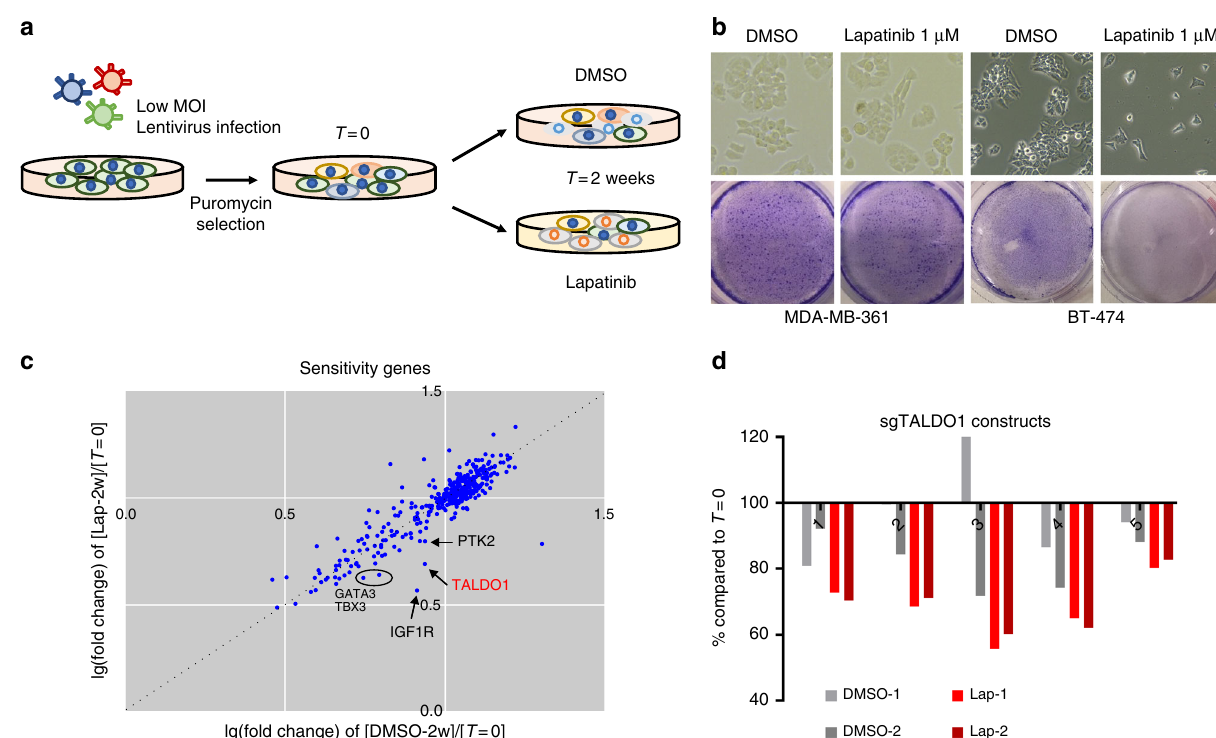
Fig. 1 Pooled CRISRP/Cas9 screening strategy identi fi es sensitivity genes. a Schematic representation of pooled CRISPR/Cas9 screening completed in MDA-MB-361 cells. Samples were collected at the indicated time points. b Bright- fi eld micrographs and crystal violet staining of cultured MDA-MB-361 and BT-474 cells treated with DMSO or 1 μ M lapatinib. c Strategy to identify sensitivity genes. The average of two biological repeats each gene depletion: x -axis as DMSO (2 weeks) compared to T = 0, y -axis as lapatinib (2 weeks) compared to T = 0, were plotted. IGF1R , TALDO1 , GATA3 , TBX3 , and PTK2 are indicated as the most differentially depleted genes after lapatinib treatment. d Depletion percentages of individual sgRNA constructs in indicated samples compared to T =